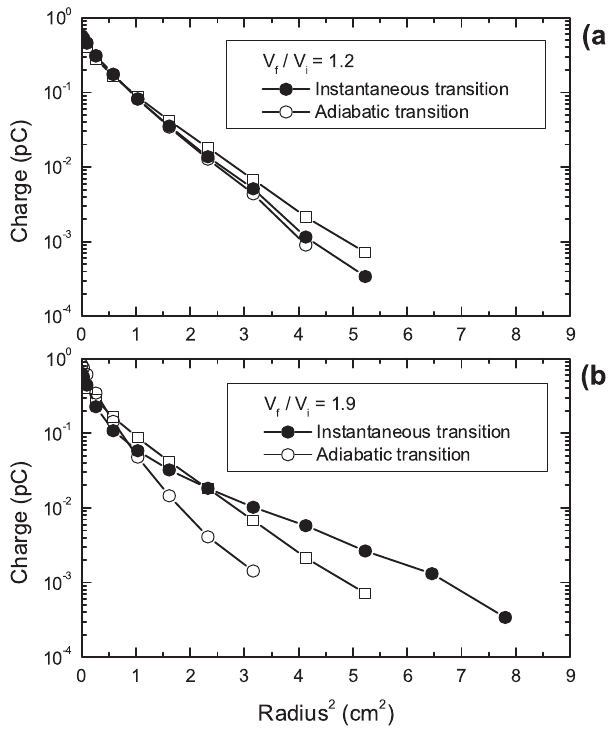
FIG. 7. Measured radial beam profiles after transitions with (a) (cid:2) 1 : 2 , and (b) V (cid:2) 1 : 9 for (cid:5) sf (cid:2) 49 : 8 (cid:3) and f (cid:2) =V =V V f i f i vi 60 kH z . The transitions are made either instantaneously (solid (cid:2) 20 (open circles). The circles), or adiabatically with N t squares in Fig. 7 correspond to the radial profile for the case (cid:2) V (no transition). A straight line in the log versus r 2 where V f i plot indicates that the radial profile is a Gaussian function of r . > 90 (cid:3) ) [2]. region for the envelope instability ( (cid:5) v ( s (cid:2) 0 : 2 – 0 : 3 ) considered in the present study, the tune (cid:15) (cid:5) 1 (cid:1) s (cid:6) 1 = 2 is approximately 0.84– depression (cid:6)=(cid:6) 0 (cid:2) 90 (cid:3) is usually 0.89, and the instability band around (cid:5) v